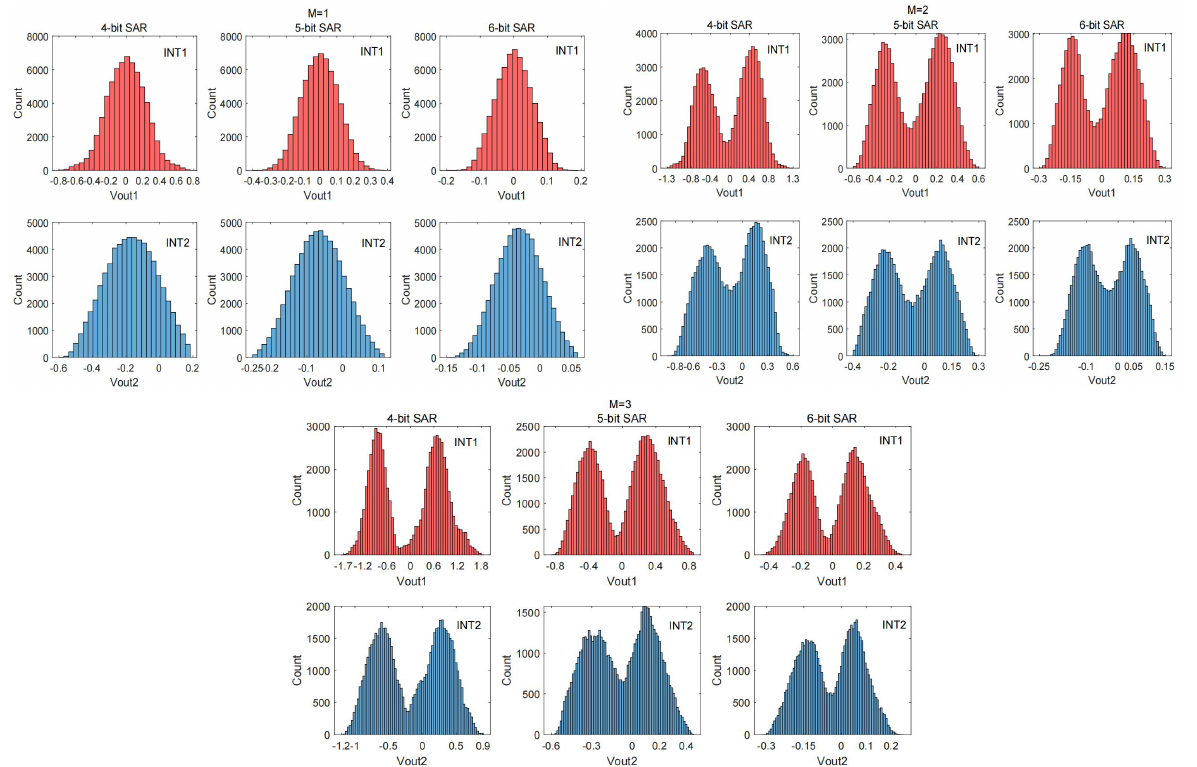
Figure 3. Output histogram of integrators INT1 and INT2 versus bits of coarse conversion